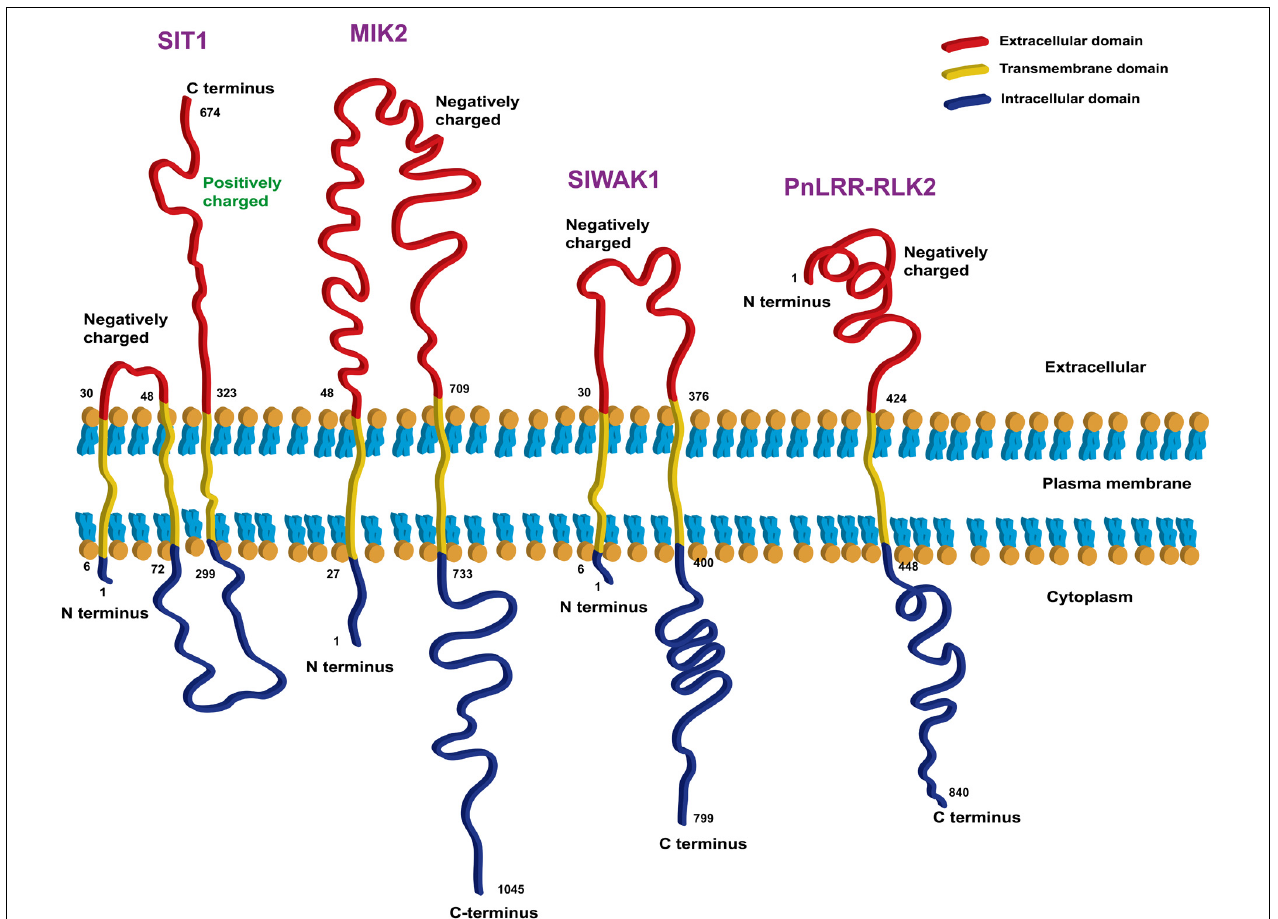
FIGURE 3 | Bioinformatic analysis of transmembrane domains of four RLKs that are candidate ionic sensors. The online tools TMHMM Server v. 2.0 (http://www.cbs.dtu.dk/services/TMHMM/) and Expasy ProtParam (https://web.expasy.org/protparam/) were used for the